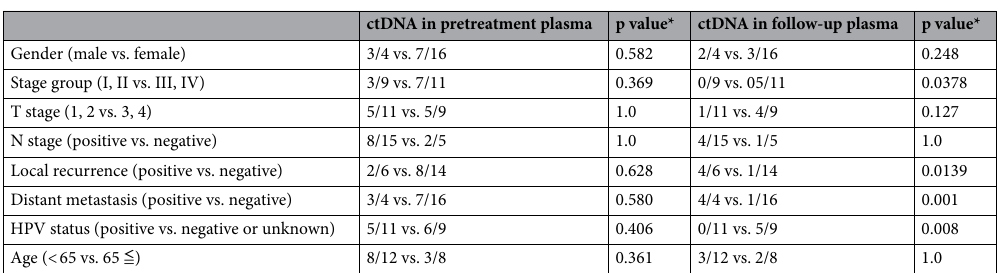
Table 2. Factors associated with ctDNA detection. *Fisher’s test. Post-treatment detection of ctDNA in plasma and Fisher test were performed for each item. Post-treatment detection was associated with stage, local recurrence, and distant